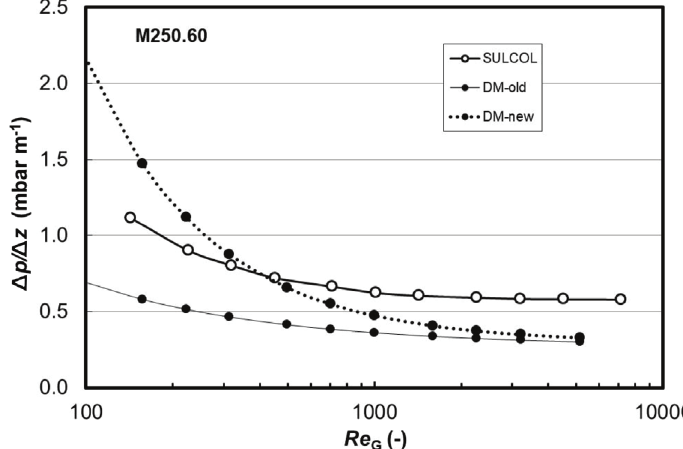
Fig. 10 – Specific pressure drop as estimated by original (DM-old) and extended DM (DM-new) for conventional struc- tured packing with a steep corrugation inclination angle (M250.60) in conjunction with given hypothetical base case, compared with SULCOL estimates for Mellapak